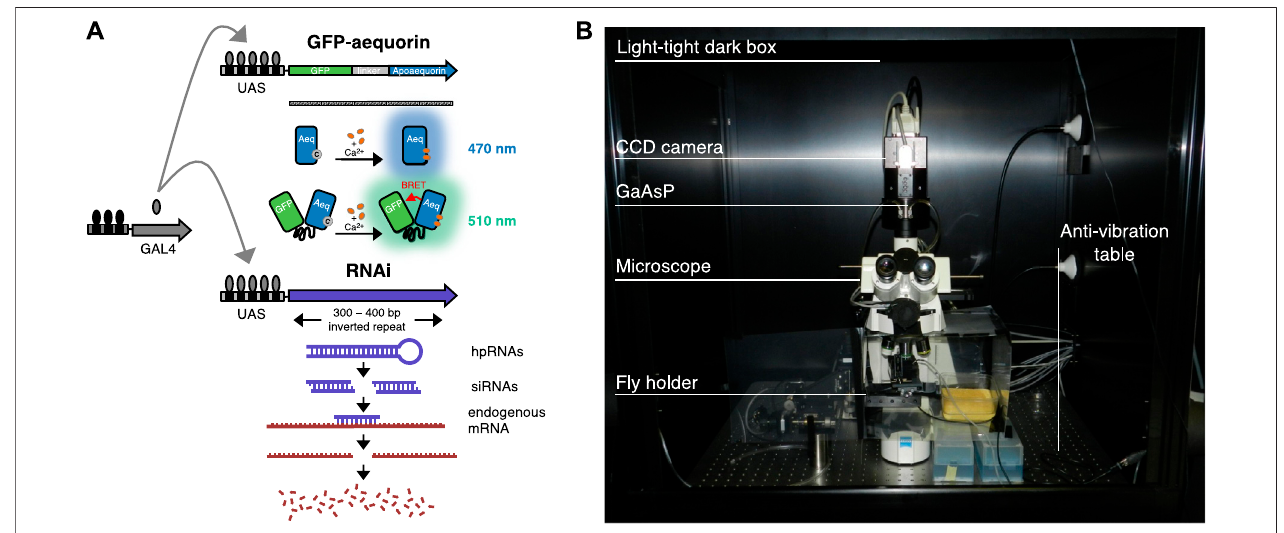
FIGURE 2 | Genetic techniques and Ca 2+ imaging setup. (A) GFP-aequorin responders activated by the driver GAL4 used in this study. On the top, schematic of GFP and aequorin fusion gene with upstream activation sequence (UAS). Models of blue light emission by aequorin (grey dot represents coelenterazine), and of green lightemissionbyGFP-aequorininresponsetohighlevelsofCa 2+ (orangedots)(imageadaptedfromXiongetal.,2014).Onthebottom,schematicoftheRNAitechnique in which a double-stranded RNA (i.e., hairpin RNA, hpRNA) is expressed under the control of UAS, as a complementary sequence to the gene of interest. The dsRNA is then processed by Dicer-2 into siRNA which leads to sequence-speci fi c degradation ofthe mRNA related to the gene of interest (image adapted from https:// stockcenter.vdrc.at/control/library_rnai). (B) Image of the setup used for in vivo Ca 2+ brain imaging based on the bioluminescence technique.